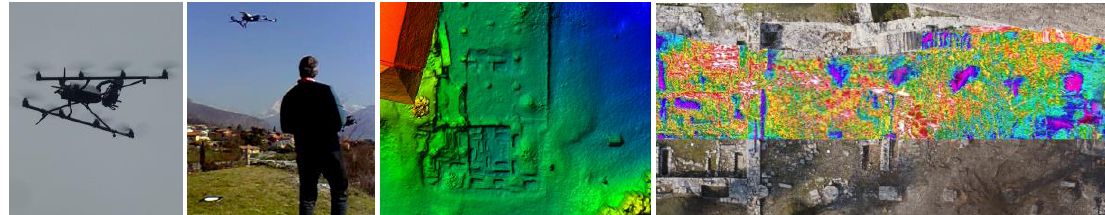
Figure 1. UAV system (Asctec Falcon 8), DEM extracted from digital images, RGB and thermal